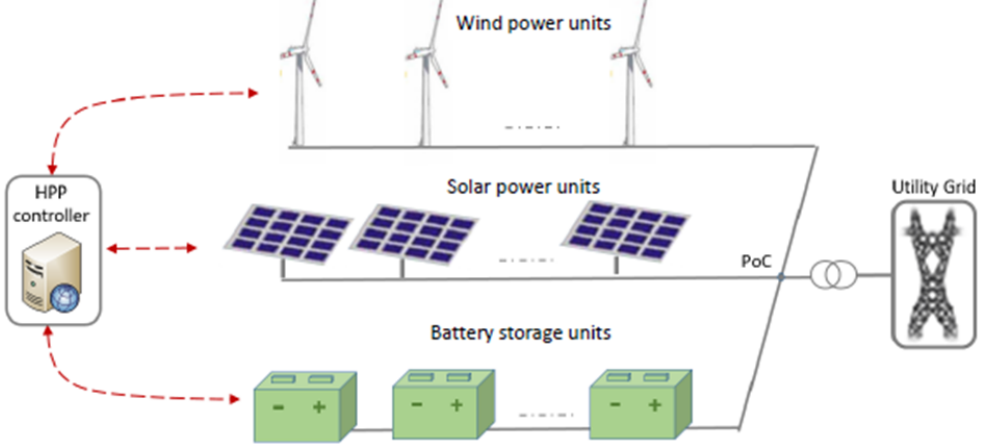
Figure 1. Utility scale wind hybrid power plant (HPP) co-located grid